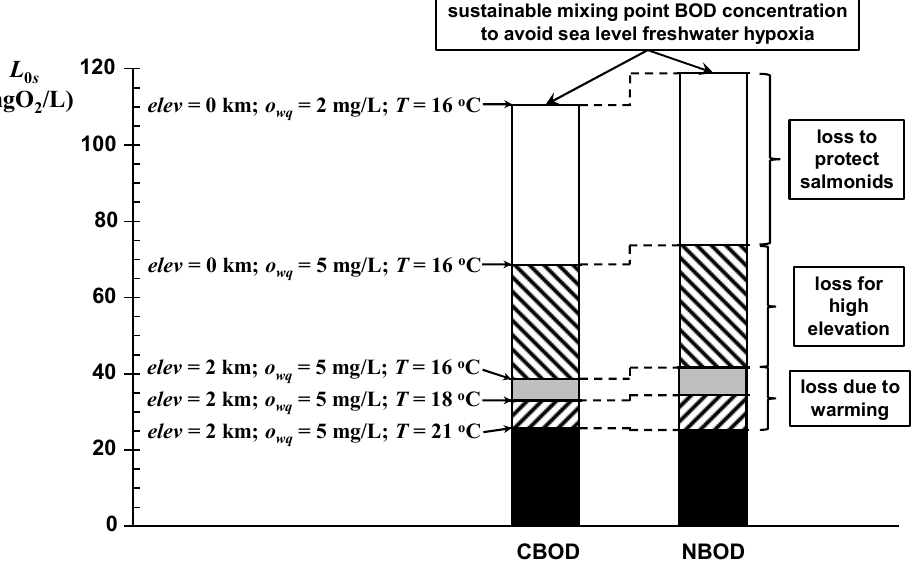
Figure 11. Bar chart depicting sustainable mixing-point BOD concentration to avoid sea-level freshwater hypoxia along with reductions due to protecting salmonid fisheries, moving from sea level to high elevation, and warming water temperatures due to climate change.